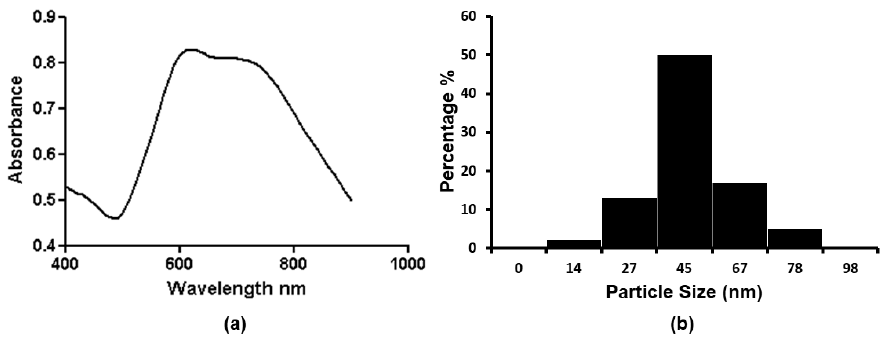
Figure 1. UV-vis absorbance spectrum ( a ) and particle size distribution ( b ) of AuNS solution.